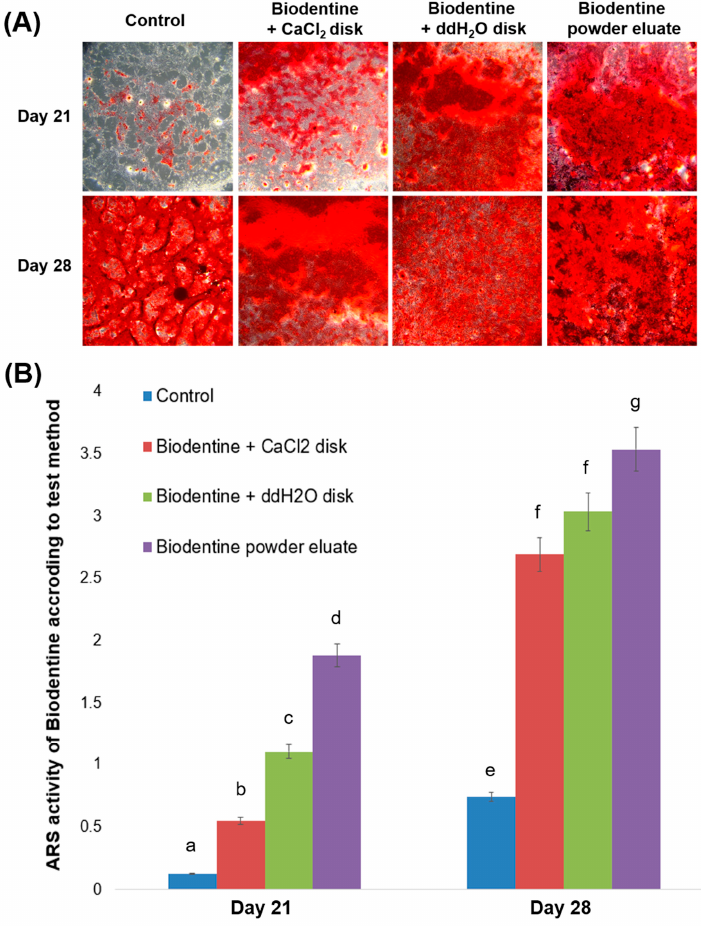
Figure 7. Calcium nodule formation according to Alizarin red S (ARS) staining assay of various Biodentine eluates according to test method. ( A ) Representative images of ARS staining assay, ( B ) ARS activity of various Biodentine eluates. Different superscript letters represent statistically significant differences.